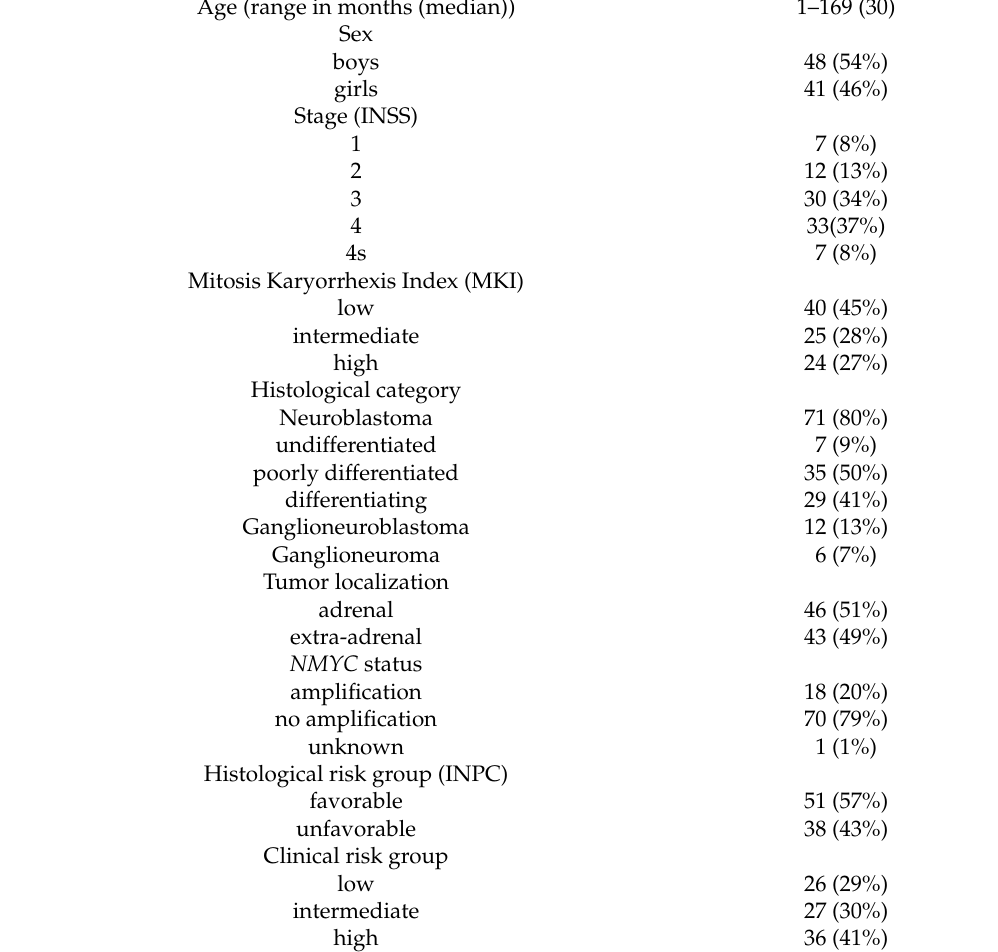
Table 1. Patho-clinical characteristics of tumours–neuroblastoma analyzed cases.